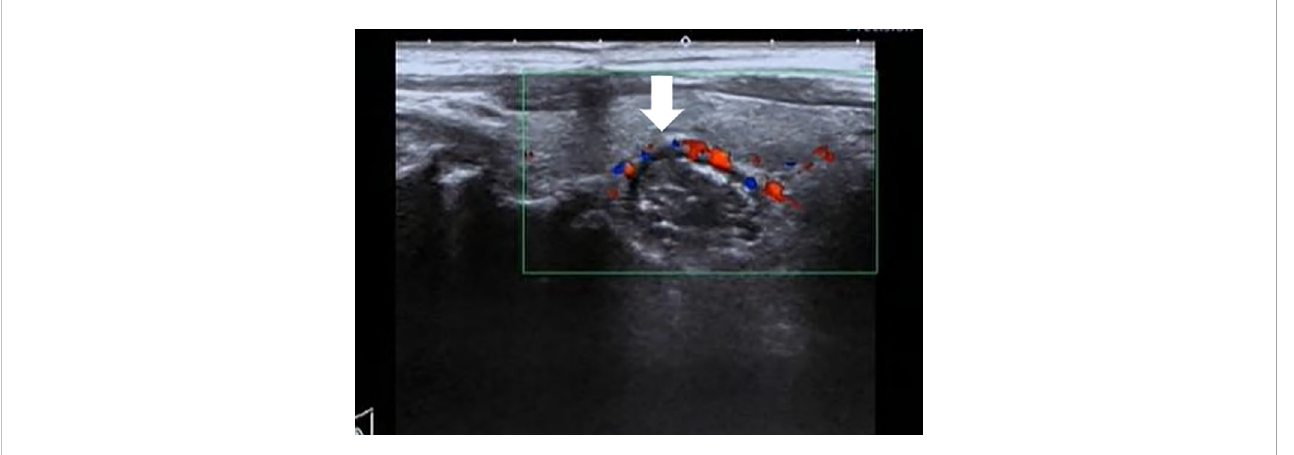
FIGURE 5 Punctate blood fl ow can be seen in the middle hypoechoic layer of the solid nodular diverticular (image from a 42-year-old